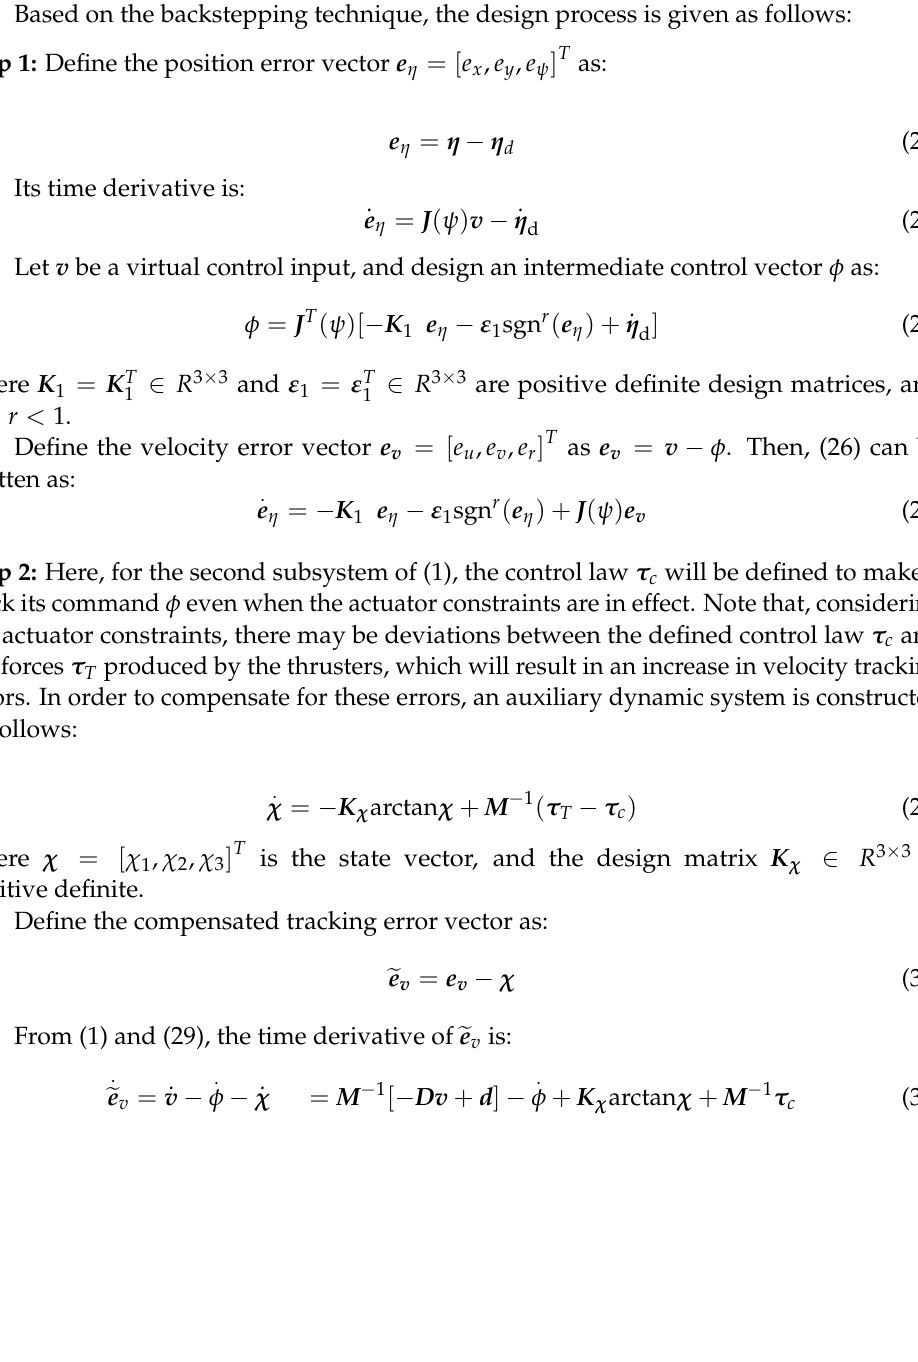
Figure 2. The structure of the DP